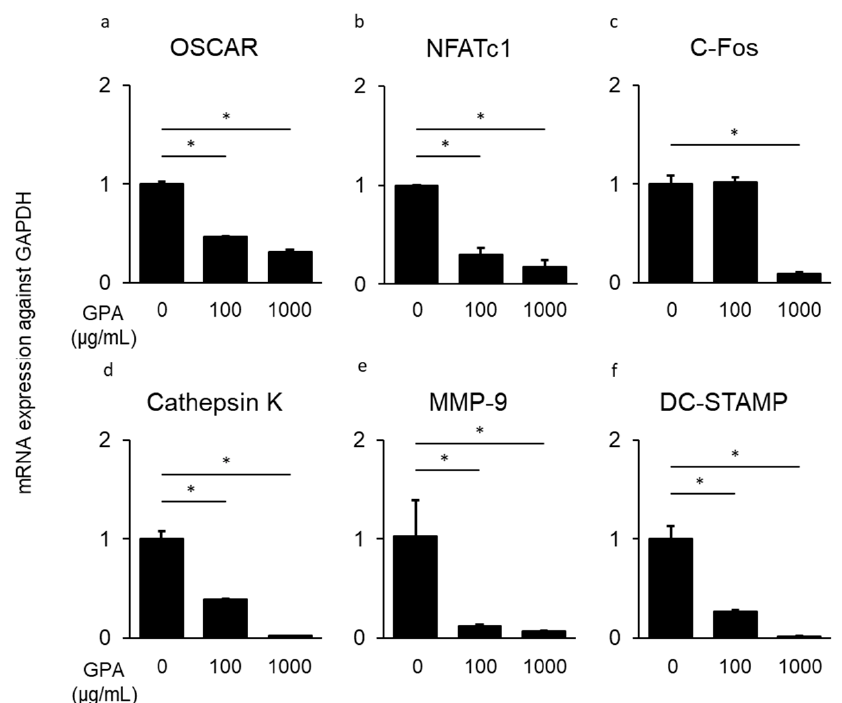
Figure 4. Inhibitory effect of geniposidic acid (GPA) on mRNA induction of osteoclast differentiation-related genes. To determine the effect of GPA in osteoclast differentiation, BMMCs were cultured with sRANKL (100 ng/mL) and M-CSF (20 ng/mL) for 48 h in the presence or absence of GPA (100 or 1000 µg/mL). mRNA expression was determined using quantitative PCR (( a ): OSCAR, ( b ): NFATc1, ( c ): c-Fos, ( d ): cathepsin K, ( e ): MMP-9, and ( f ): DC-STAMP). * Significantly higher mRNA expression of genes by Student’s t -test (* p < 0.01).